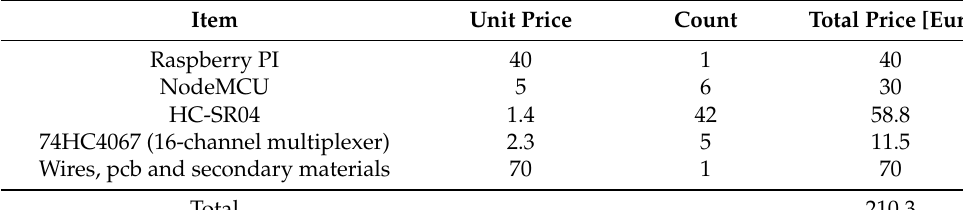
Table 3. Cost of system